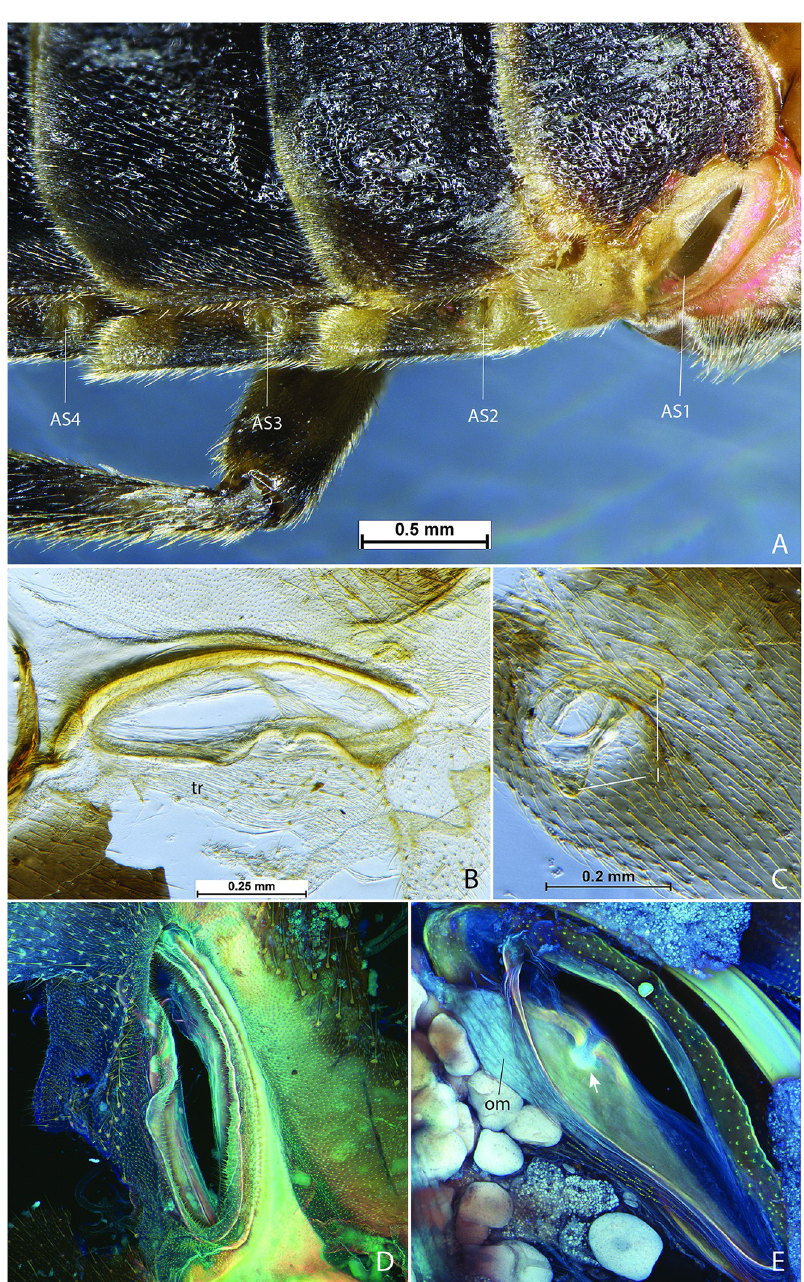
Fig 15. Adult male abdominal spiracles in Photinus pyralis . A, right half of abdomen, dorsal view showing spiracles 1–4; B, segment I spiracle, external view; C, segment III spiracle, external view; D, segment I spiracle, external view; E, segment I spiracle, internal view showing occlusor muscle. Abbreviations: l, lever; om, occlusor muscle; tr, trachea. visualized by capturing a certain range of blue-spectrum autofluorescence [30], this area likely contains more resilin to allow flexion (closing) of the spiracular lip. In contrast to this large anterior spiracle, the smaller spiracles on segments II–VIII possess a short atrium that leads to an internal pair of digitiform lever arms (the closing mechanism) connected by the occlusor muscle [31] (Figs 16F, 22A and 22B). Between the lever arms is an area of different cuticular